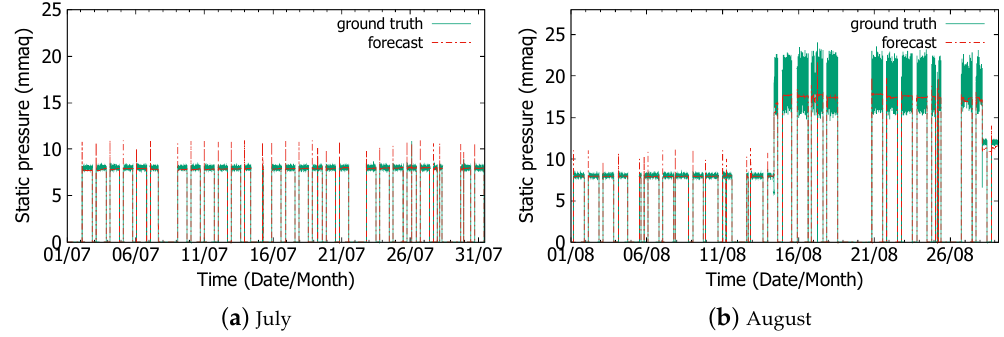
Figure 17. Out-of-season forecast results of the LSTM-based predictor trained using data from May. The error values for August are an MAE of 0.617 mmAq, MAPE of 3.876%, and RMSE of